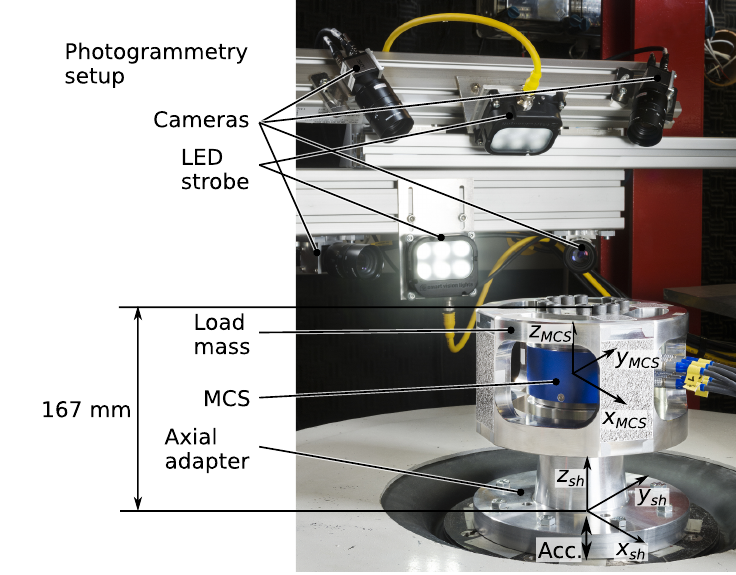
Figure 5. Photogrammetric set-up in the shaker